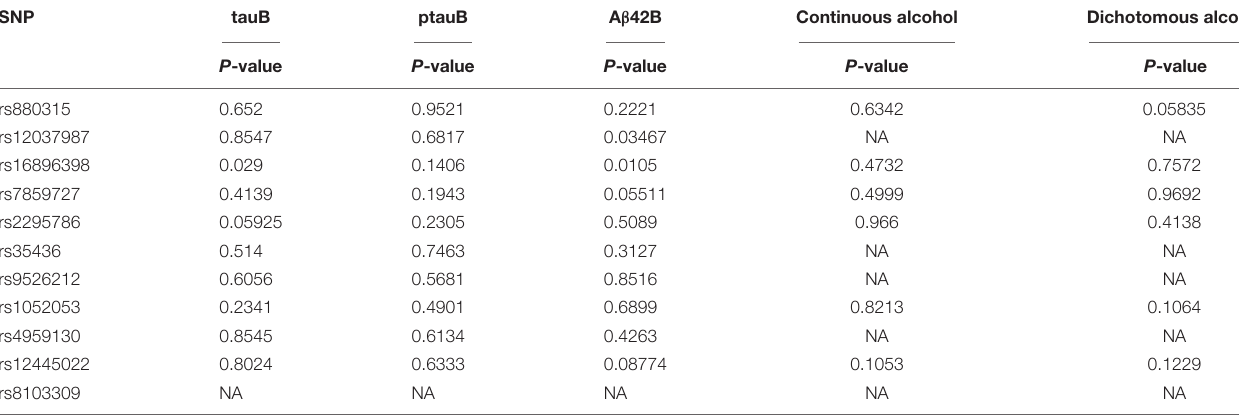
TABLE 5 | P -values for 11 genetic variants with three AD marks (tauB, ptauB, A β 42B) and alcohol phenotype.